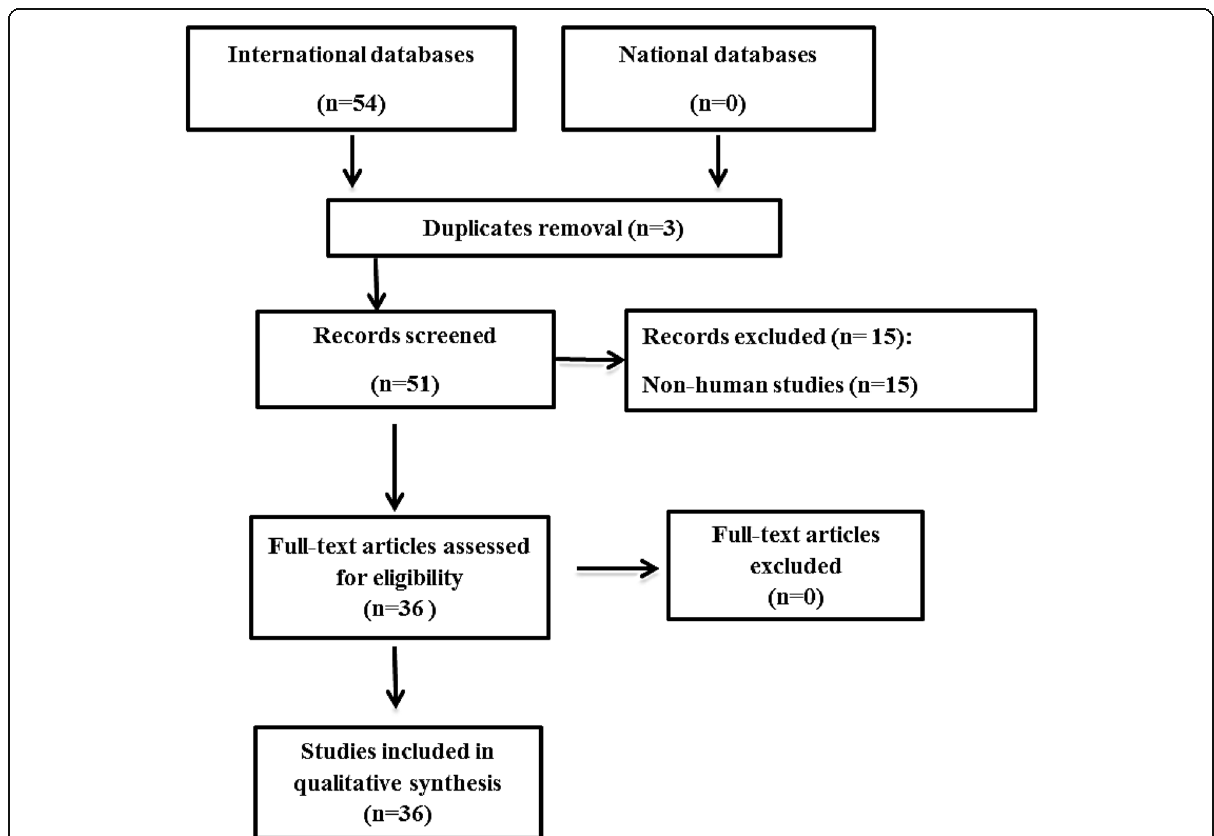
Fig. 1. Diagram of included studies into the systematic